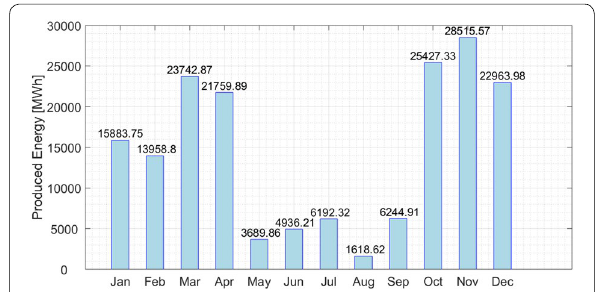
Table 5 Terceira system design data with